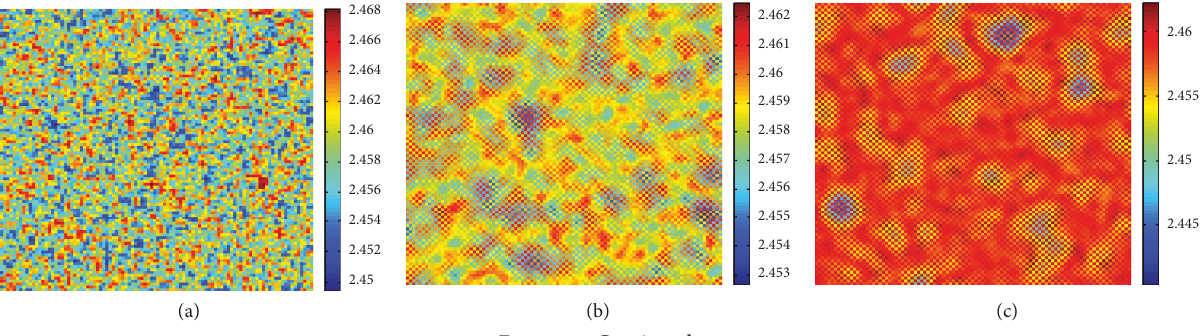
� 1 . 220, d � 0 . 20; (b) d � 1 . 390, d � 0 . 20; (c) d � 1 . 389, 1 2 1 2 1